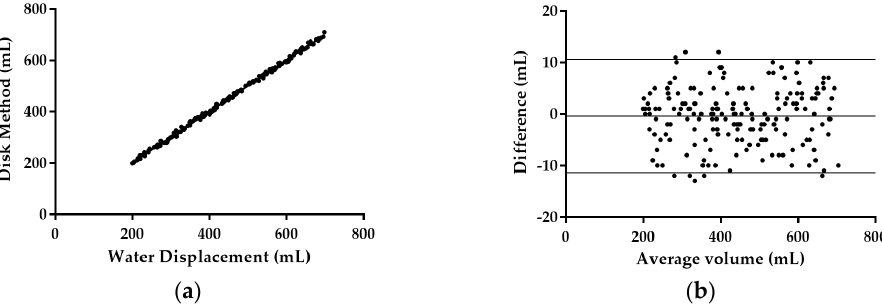
Figure 13. ( a ) Plot of mango volume measure by disk method estimation and water displacement method with regression line (R 2 ); ( b ) Bland-Altman plot for comparing difference and average of water displacement method and disk method; outer line indicate 95% limits of agreement and center line show the average difference.